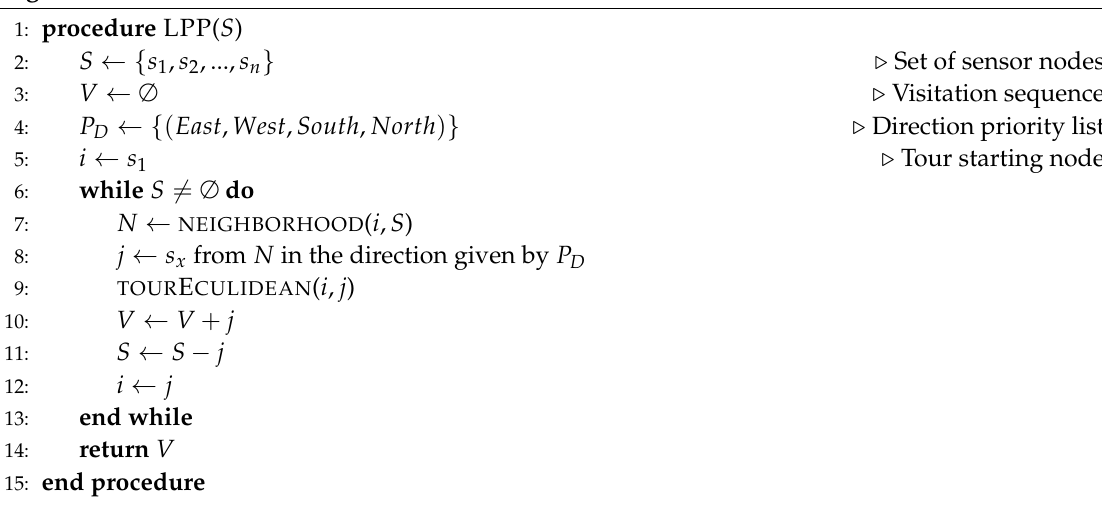
Algorithm 1 Shortest Path Lawn-Mower Path Planner– LPP